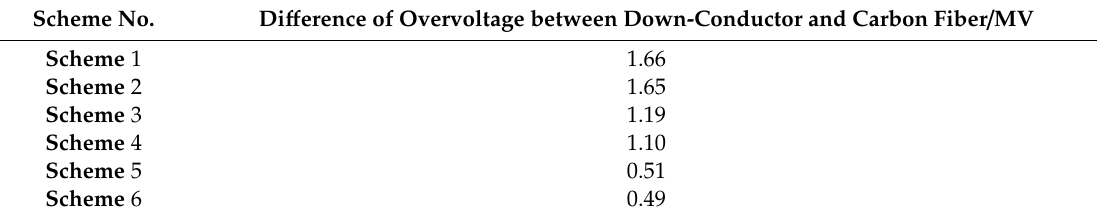
Table 5. Voltage between the down-conductor and CFN with various installation schemes. Scheme No.